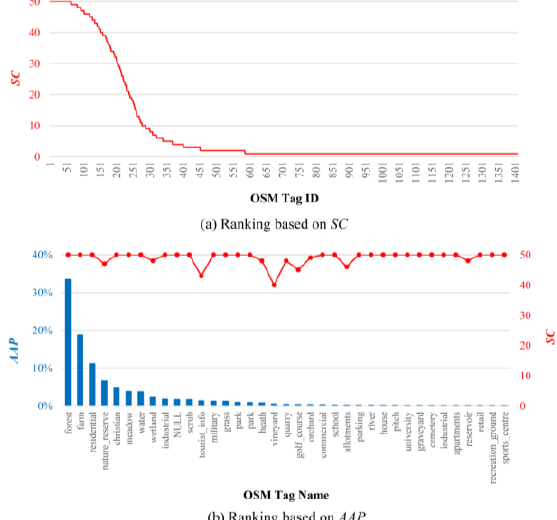
Figure 3 . Ranking OSM tags according to SC (a) and AAP (b).